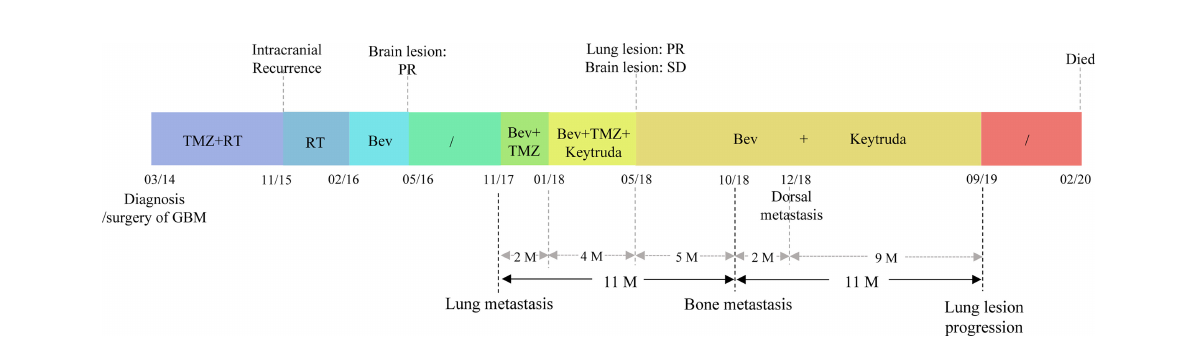
FIGURE 1 The treatment timeline of the patient. The patient was diagnosed with glioblastoma in March 2014. He underwent surgery, followed by standard adjuvant treatment with Temozolomide (TMZ) and radiotherapy (RT). The tumor recurred intracranially in November 2015, and he received RT and Bevacizumab (Bev) treatment, the response evaluation of the brain lesion was a partial response (PR). In November 2017, lung metastases were detected, the patient accepted Bev and TMZ, but the lung lesion progressed. Two months (M) later, Keytruda was added because of a positive PD-L1 expression and a partial response (PR) was achieved for the metastatic lesion while the brain lesion was a stable disease (SD). Then TMZ was discontinued to relieve the symptoms of fatigue and due to the unmethylation of the MGMT promoter (May 2018). The